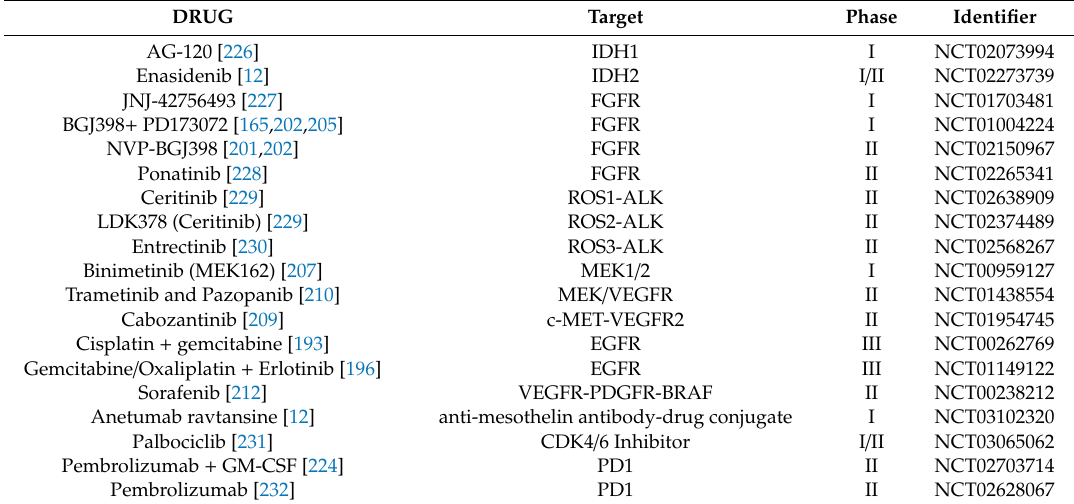
Table 2. Targeted therapies against